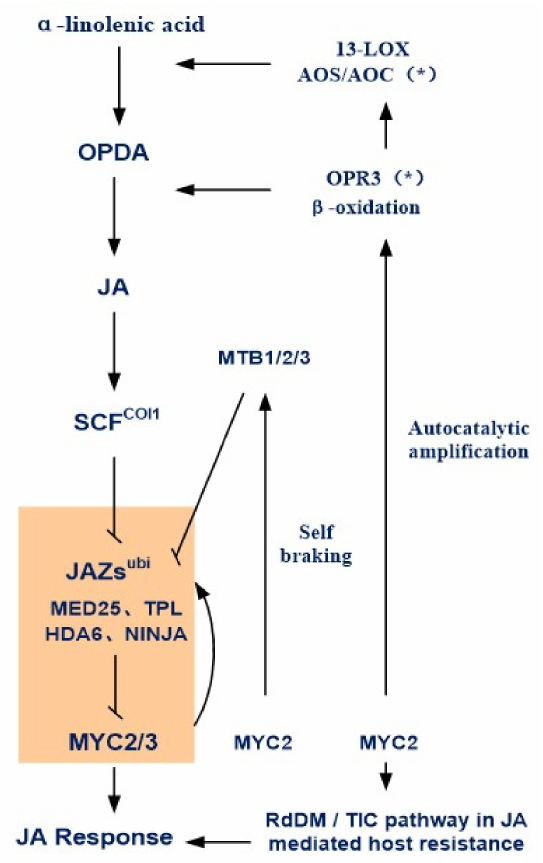
Figure 3. Schematic diagram of jasmonate signal induction and the self-regulation